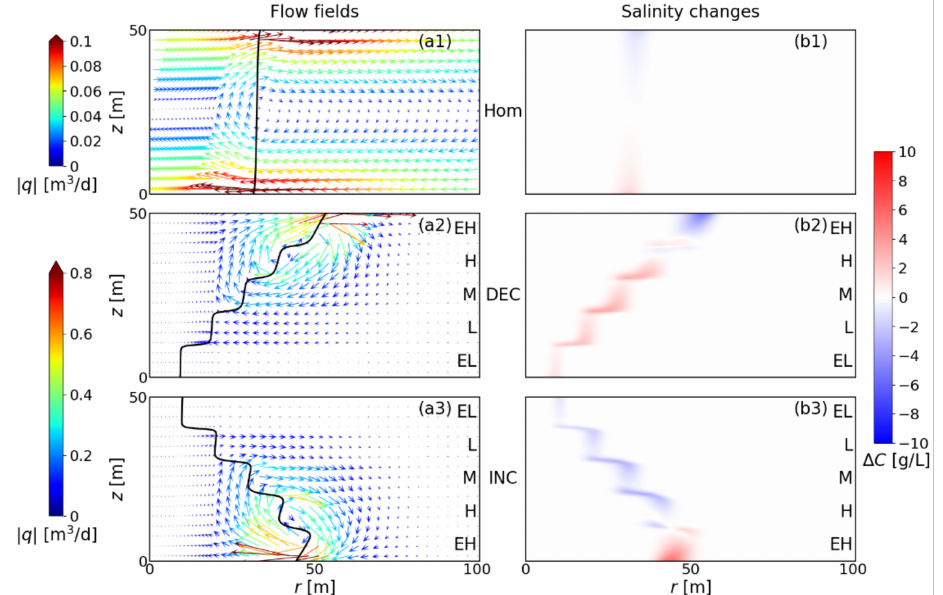
Figure 3. Flow field distributions at the intermediate storage phase (i.e., after 82 days of storage; a1 – a3 ) and the salinity changes during storage (i.e., concentration difference between the end and start of the storage phase; b1 – b3 ) for the first ASR cycle. Results shown are for the equivalent homogeneous case ‘Hom’ (top), and the heterogeneous cases ‘DEC’ (middle) and ‘INC’ (bottom). The black lines represent the contour of C = 5 g/L, indicating the approximate location of the fresh-saline